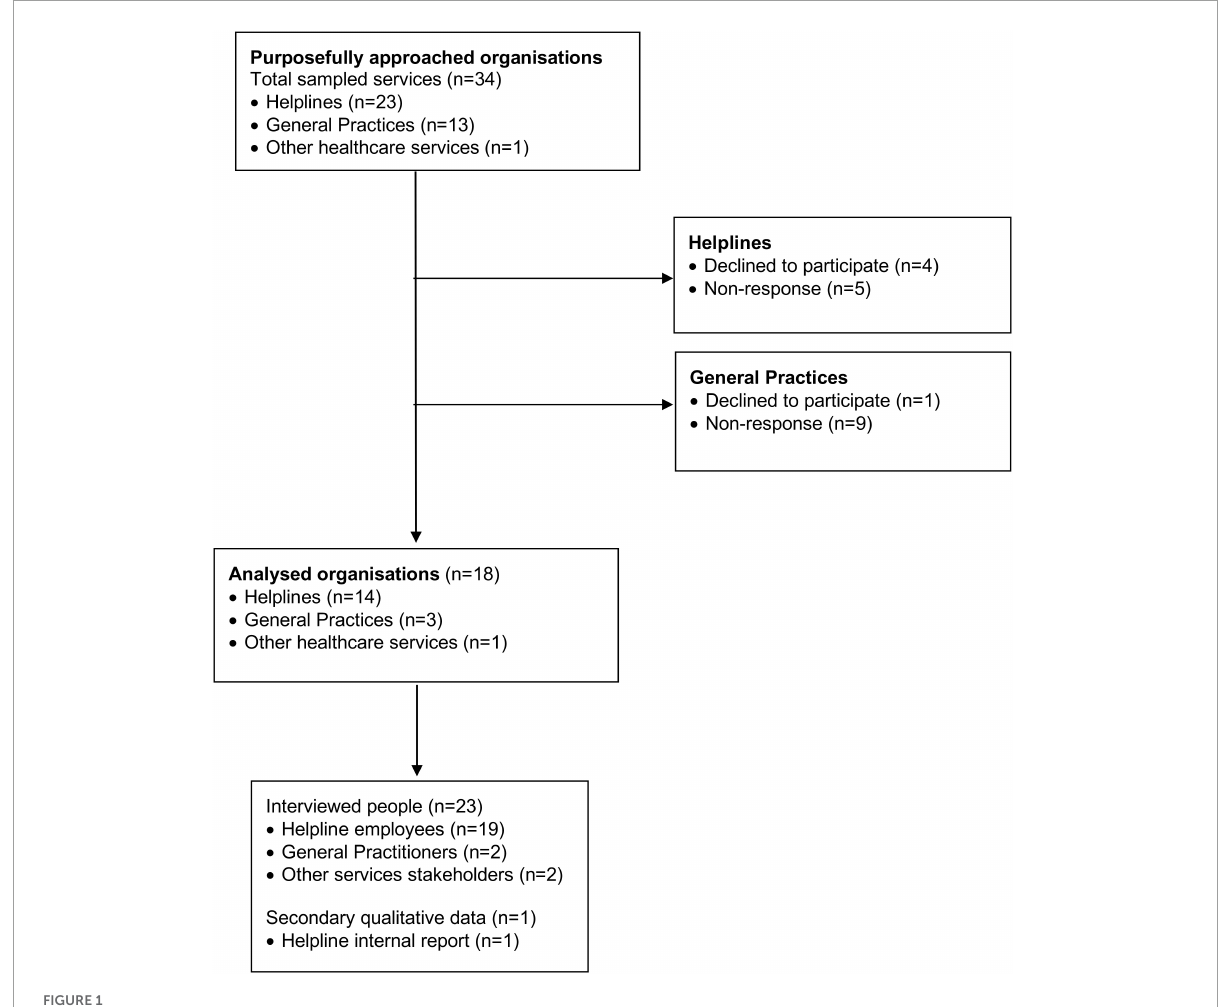
FIGURE1 Data collection flow